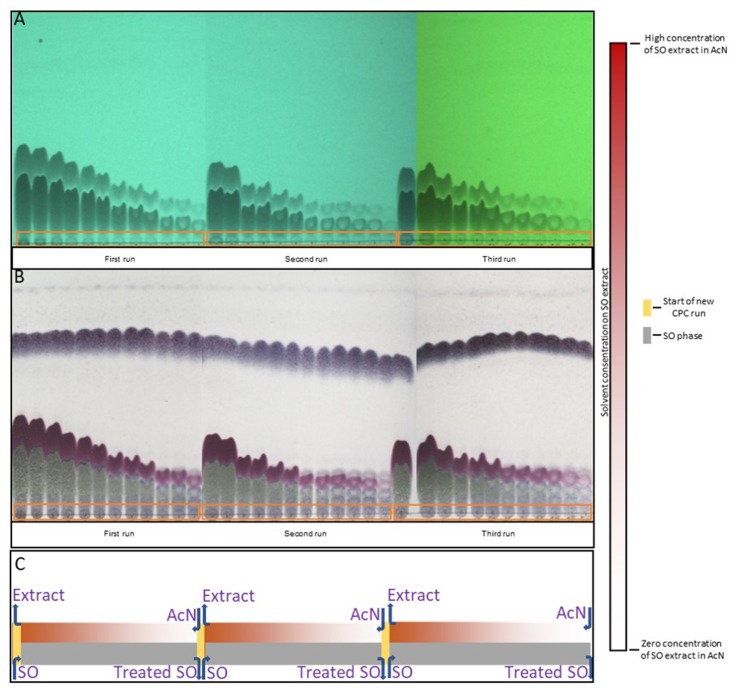
TLC analysis of CPE fractions from three continuous runs in 254 nm (A) and in visible sprayed with vanillin solution (B). Schematic presentation of concentration of extraction solvent in lignans during the extraction process (C).